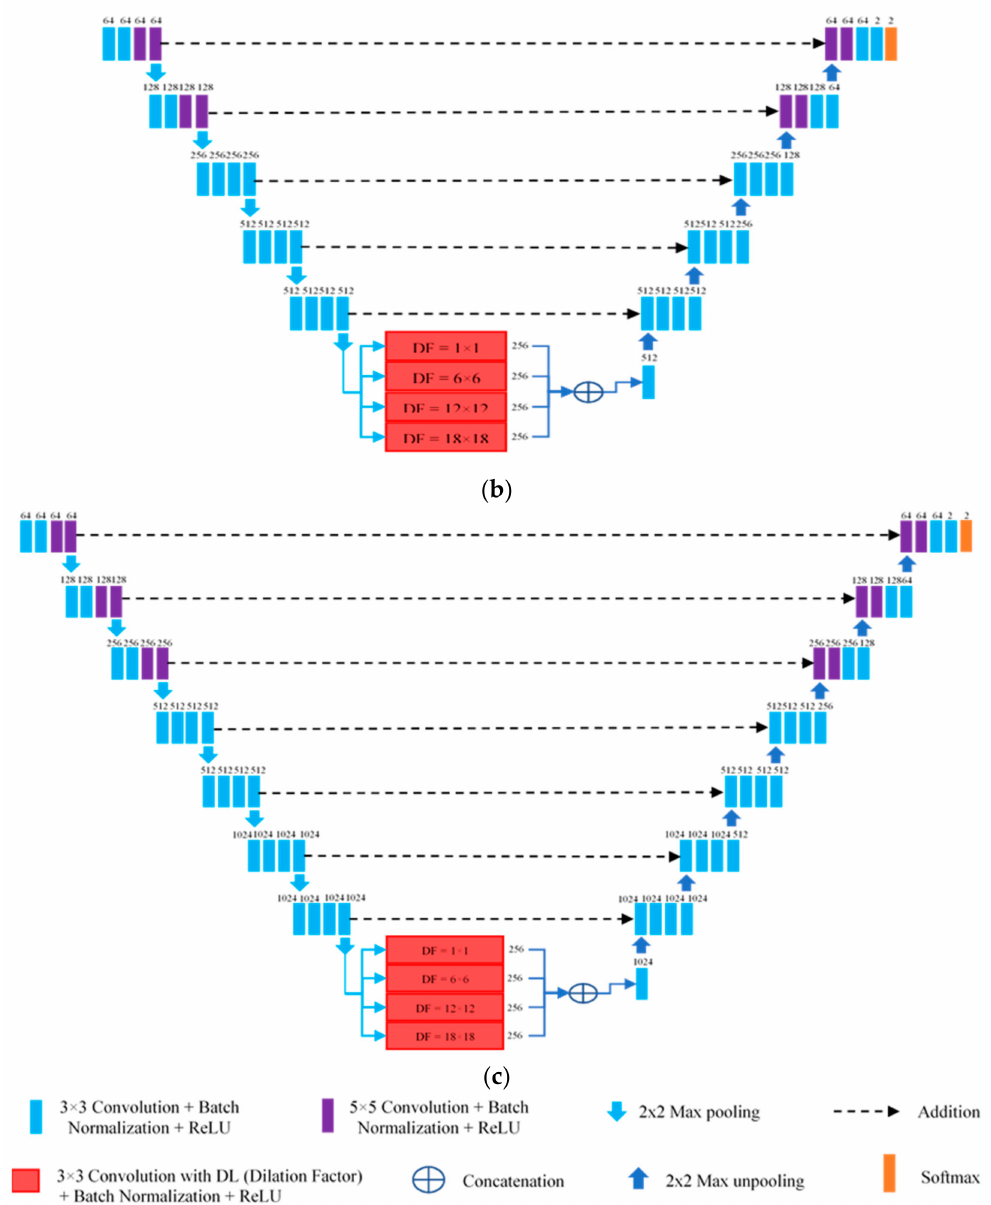
Figure A2. An overview of our three proposed networks: ( a ) 100-layer network; ( b ) modified SegNet (154-layer network); ( c ) 208-layer network. The small numbers represent the number of image channels used in each convolution